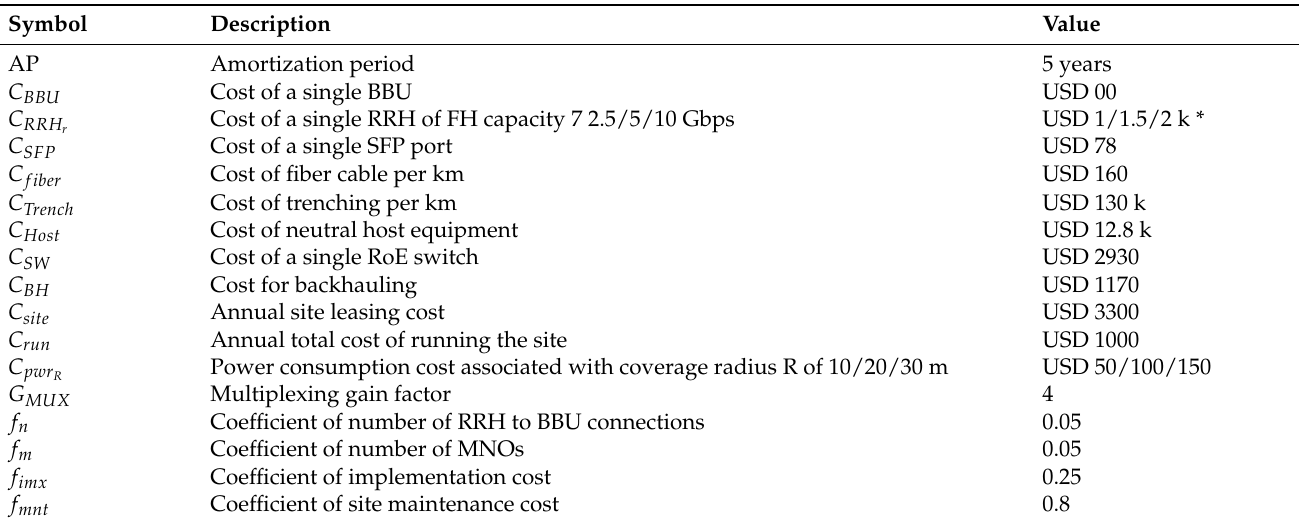
Table 1. Simulation